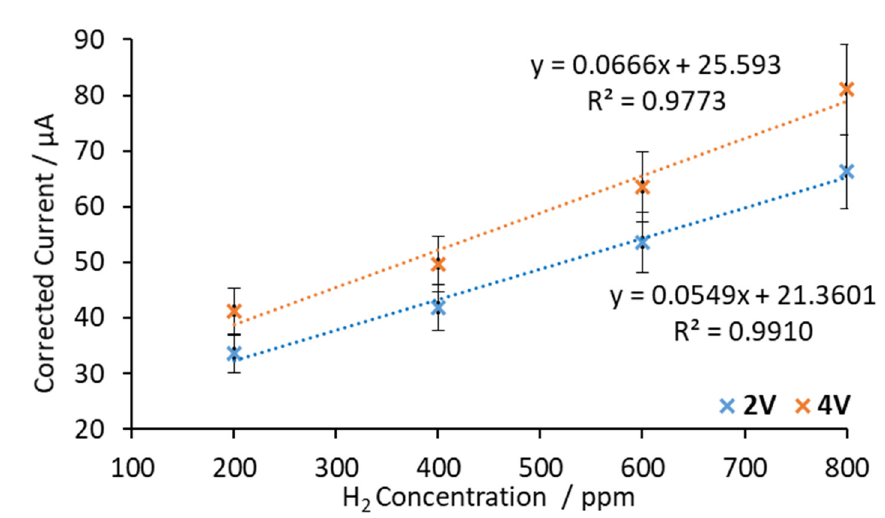
Figure 7. Calibration curves obtained with SrCeZrYb at 600 °C by applying 2 V and 4 V between electrodes.